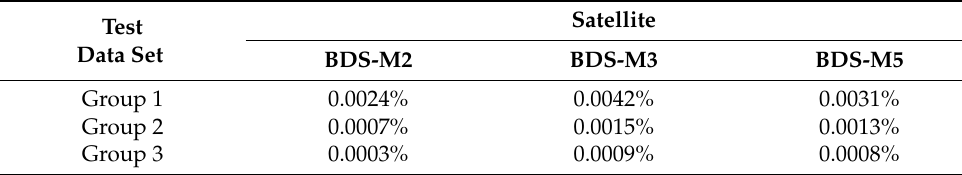
Table 3. The false alarm rate of our model for different satellite data.